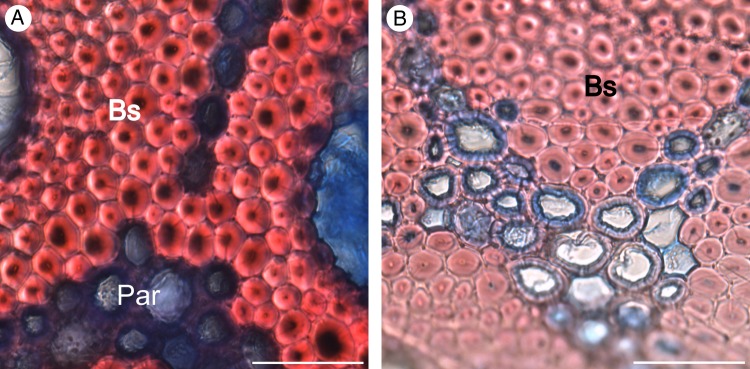
Fusion of bundle sheaths observed in the periphery of older stems (A) and lignification of parenchyma between bundle sheaths (B). Par, parenchyma; Bs, bundle sheath. Scale bars are 50 µm.